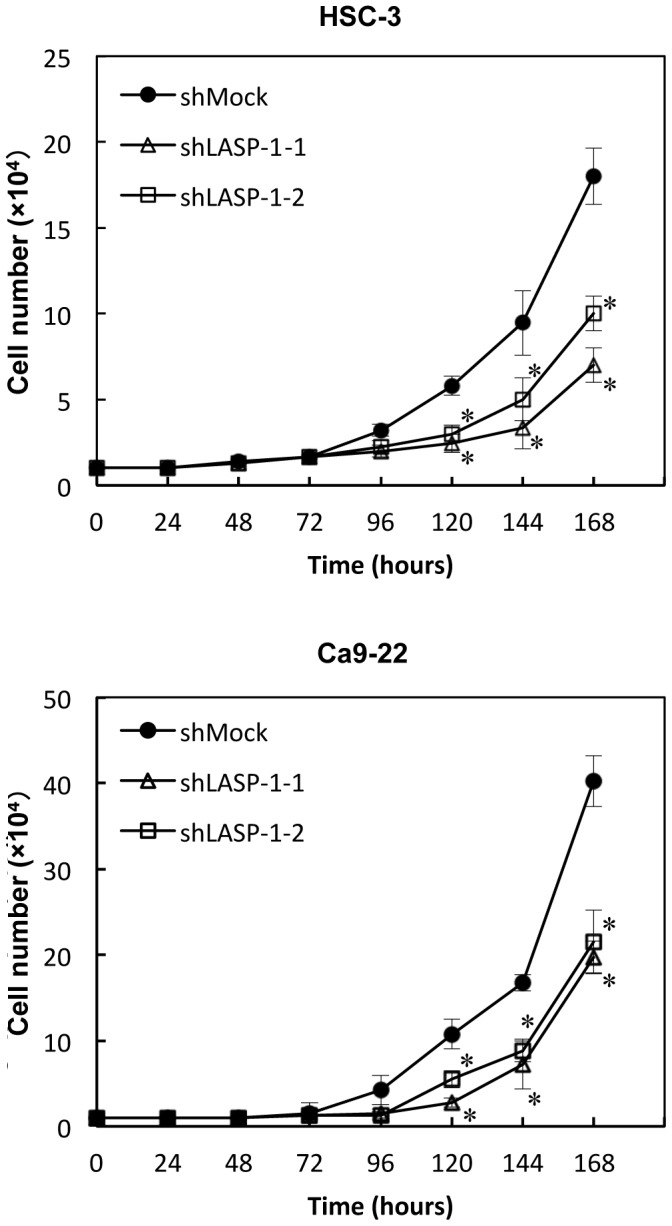
Proliferation of shLASP-1-transfected cells.To determine the effect of shLASP-1 on cellular proliferation, shLASP-1- and shMock-transfected cells were seeded in six-well plates at a density of 1×104 viable cells/well. The shLASP-1 transfected HSC-3 and Ca9-22 cells have a significant (*P<0.025; Mann-Whitney U test with Bonferroni correction) decrease in cellular growth compared with the shMock-transfected cells.